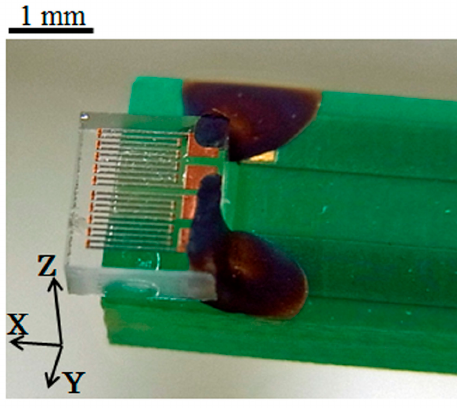
Figure 1. View of the sensor element.